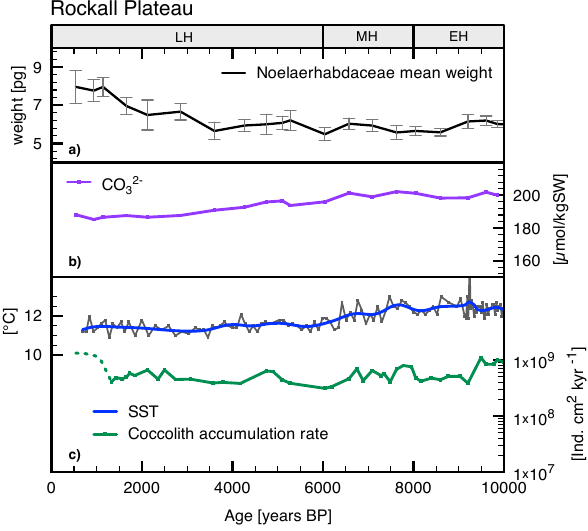
Fig. 9. Azores, core Geofar KF 16. (a) Noelaerhabdaceae mean coc- colith weight (black line); error bars indicate 95% confidence in- tervals of the mean weight. (b) Carbonate ion concentration (purple line) (c) SST (Schwab et al., 2012; blue line) and coccolith accumu- lation rate (Schwab et al., 2012; green line). Bold lines are smoothed (by factor of 4), and grey thin lines represent original data.